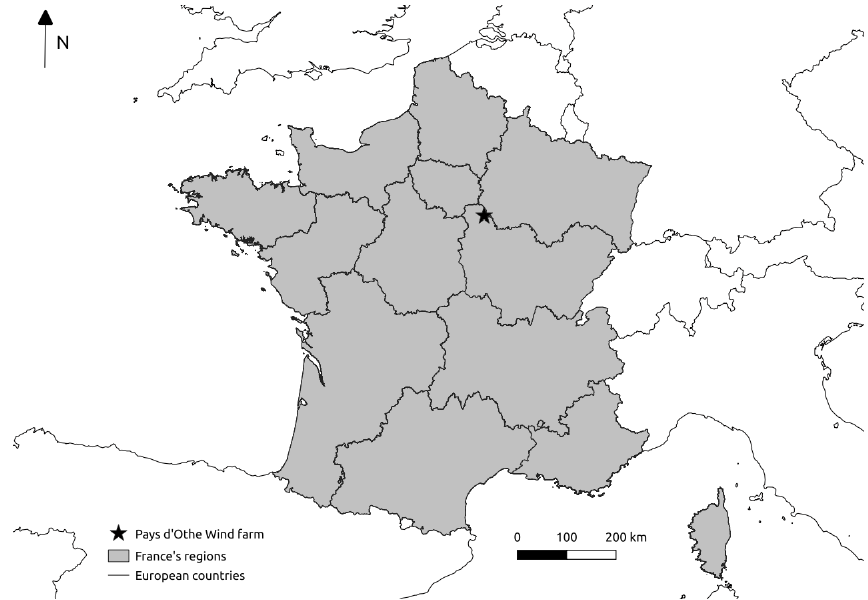
Figure 1. Location of the Pays d’Othe wind farm in France, where the data presented in this paper are collected